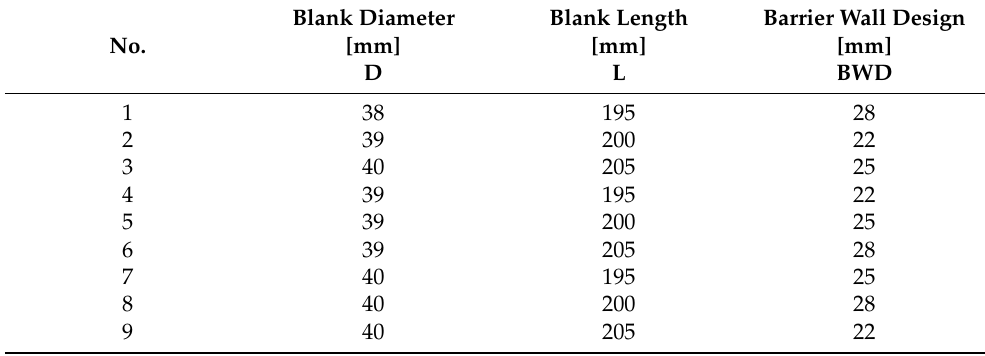
Table 7. L 9 (3 3 ) orthogonal array of process parameters.